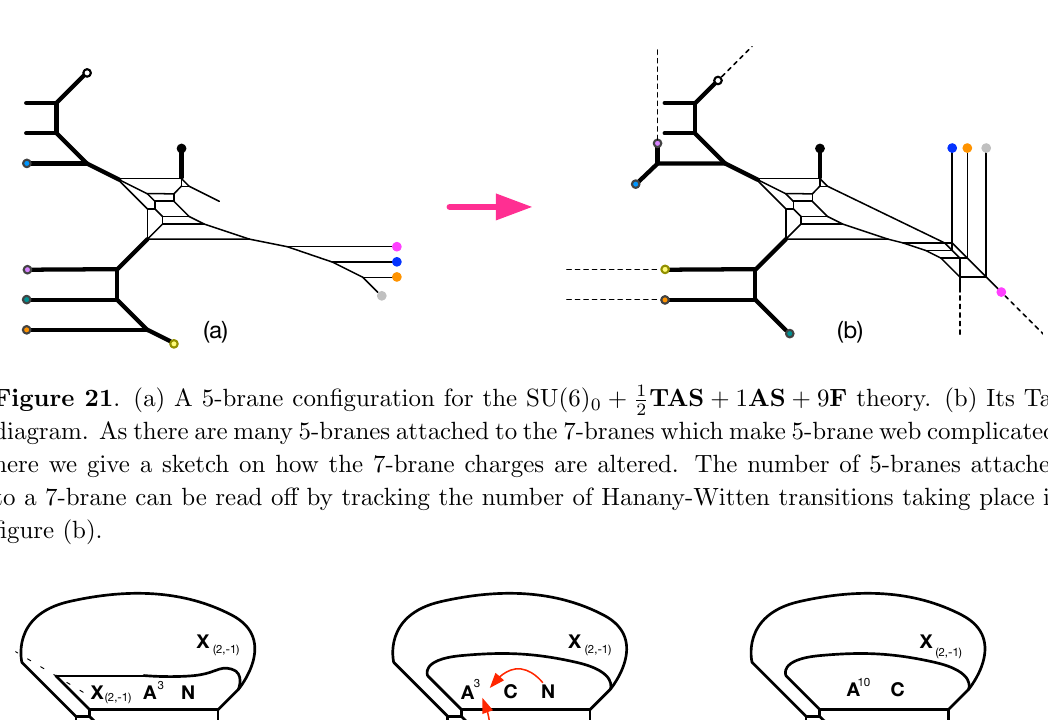
Figure 22 . A 7-brane con(cid:12)guration of a web diagram for the SU(6) 0 + 1 TAS + 1 AS + 9 F theory. 2 (a) A 7-brane con(cid:12)guration for the 5-brane web given in (cid:12)gure 21(a). (b) In the upper chamber, using (3.3), N A 3 X = N CA 3 (c) The resulting 7-brane con(cid:12)guration after moving 7-branes ( (cid:0) 2 ; 1) along the red arrows in (cid:12)gure (b) with NC = CA . The non-abelian part of global symmetry SU(10) is obtained from the 7-brane con(cid:12)guration A 10 in a chamber of 5-brane loops.